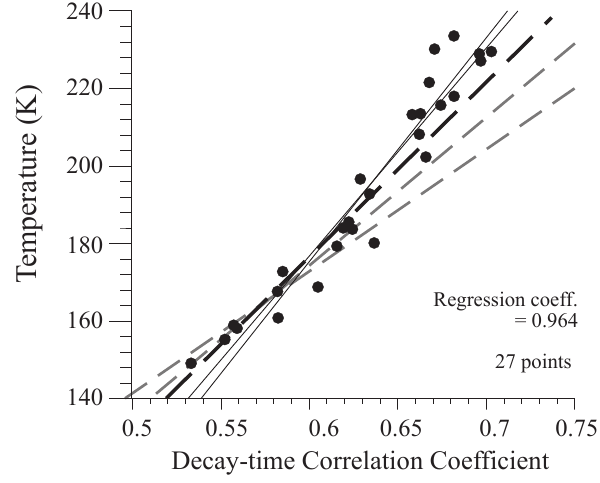
Fig. 4. Fig. 4. The points represent the decay-time correlation coefficients deduced from our numerical model for various assumed tempera- tures (ordinate), using different assumed random number seeds and different assumed initial temperatures. The two thin solid lines rep- resent best line fits to the data, assuming zero error in the tempera- ture (steepest line) and then zero error in the correlation coefficient (shallower line). The broken lines represent experimental fits from Fig.